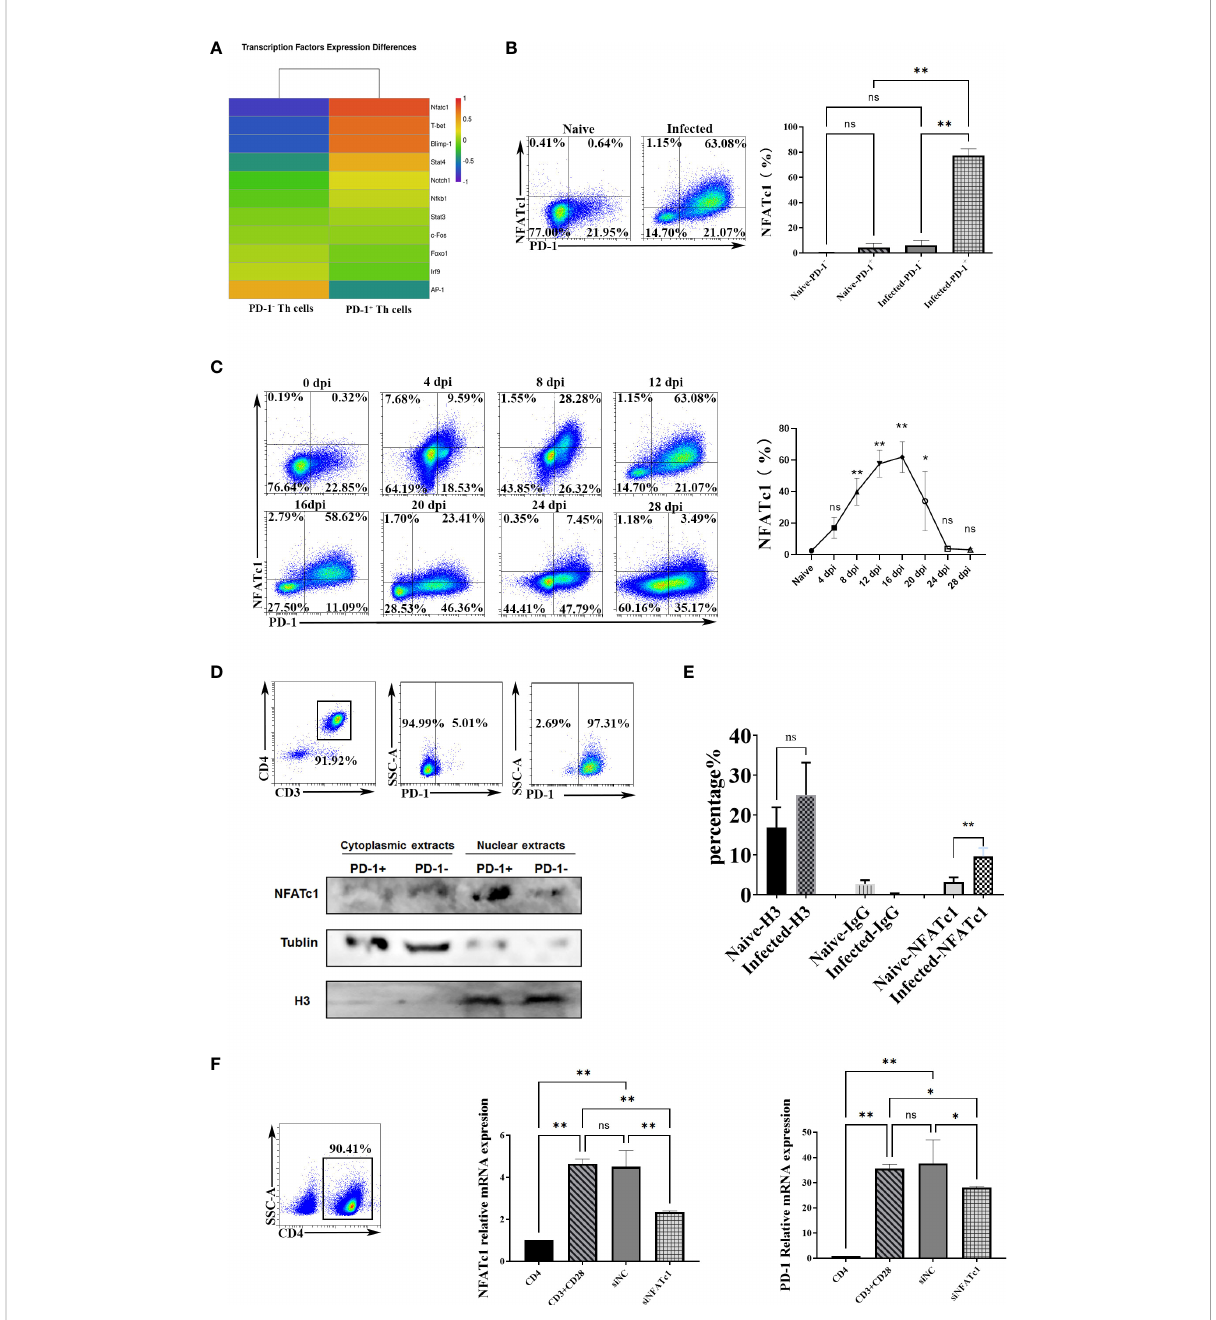
FIGURE 4 P. yoelii infection induced PD-1 expression through NFATc1. (A) the expression of the reported 10 transcriptional activators/repressors from the sequencing data. (B) the expressions of NFATc1 in PD-1 +/- CD4 T cells were examined by FCM. (C) the dynamic changes of NFATc1 expression in CD4 T cells of P. yoelii -infected mice were monitored from 0-28 days. (D) the PD-1 + and PD-1 - CD4 T cells from the spleen of mice infected with P. yoelii were sorted. The cytoplasmic and nuclear proteins were extracted, and the expression of NFATc1 was detected by Western. (E) in the ChIP experiment, anti-histone H3 antibody, and normal IgG were set as controls. Anti- NFATc1 antibody was used to pull down the binding DNA sequences. Then, qPCR was used to detect the binding ef fi ciency. (F) CD4 + T cells were sorted by magnetic beads and stimulated. siRNA was then used to interfere with NFATc1. The expression of NFATc1 and PD-1 was detected by qPCR. 3 – 7 samples